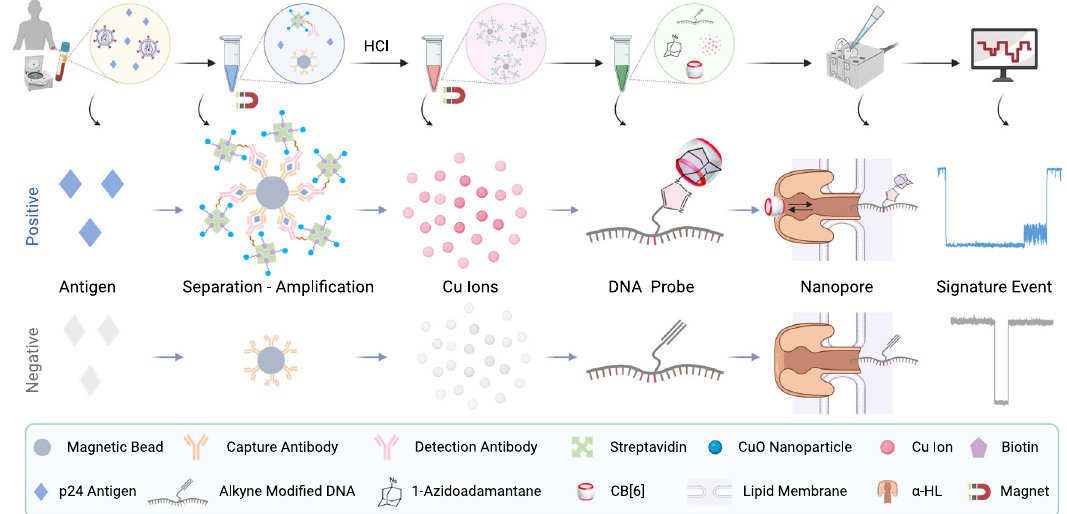
Fig. 1 | Illustration of the click chemistry ampli fi ed nanopore (CAN) assay work fl ow for quanti fi cation of HIV-1 p24 antigen in human serum. (1) blood samples were collected into serum separator tubes, and sera were collected after centrifugation and clot formation; (2) serum samples were incubated with capture antibody-modi fi edmagneticbeads(MBs)anddetectionantibody-modi fi edcopper oxidenanoparticles(CuONPs)toformasandwichstructurebetweenMBs,enriched